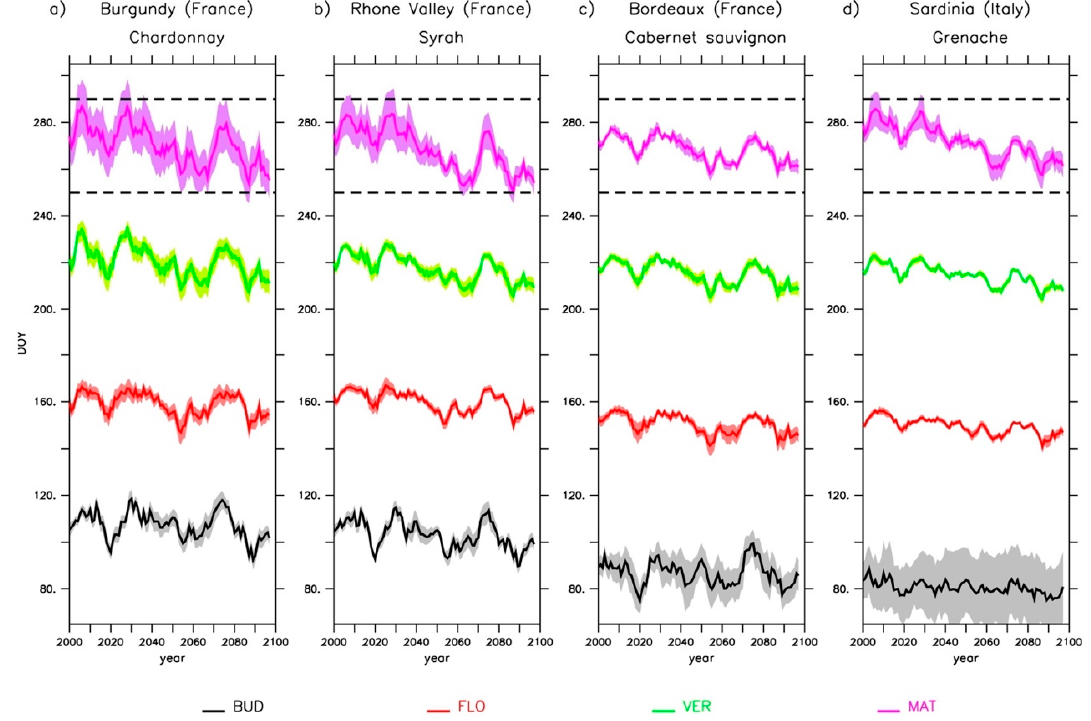
Figure 5. Evolution of day main phenological phases (in day of year (DOY)) of typical grapevine varieties in four selected renowned wine-making regions of Europe: ( a ) Chardonnay in Burgundy, ( b ) Syrah in Rhone Valley, ( c ) Cabernet Sauvignon in Bordeaux, and ( d ) Grenache in Sardinia, as simulated by the downscaled CSIRO-Mk3-6-0 model. Results are based on the ensemble mean of the three phenological models here adopted. Black lines indicate the budburst, red lines the flowering, green lines the veraison, and violet lines the maturity evolution, while their shaded intervals represent the two-sigma spread between the three phenological models. Dashed lines indicate the limits for maturity day within which climate conditions are suitable for premium wine production according to the definition in Methods and Materials.